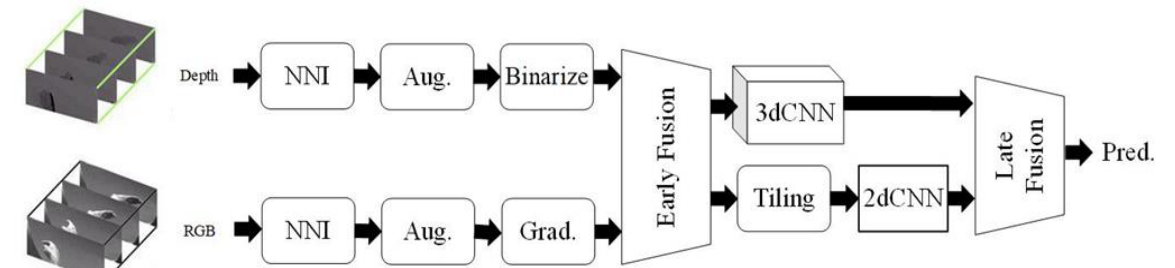
Figure 1. Block diagram of the proposed method. Input is the RGB and depth modalities of hand gesture videos, and the output is the predicted label. The following modules are used in the framework. NNI: Nearest Neighbor Interpolation, to fix video lengths; Aug: Data Augmentation. Binarize layer generates a binary image from depth data. Grad. Layer calculates Gradient from intensity channel of color data using Canny operator, Tiling, generates a 2D pattern from sequence of video